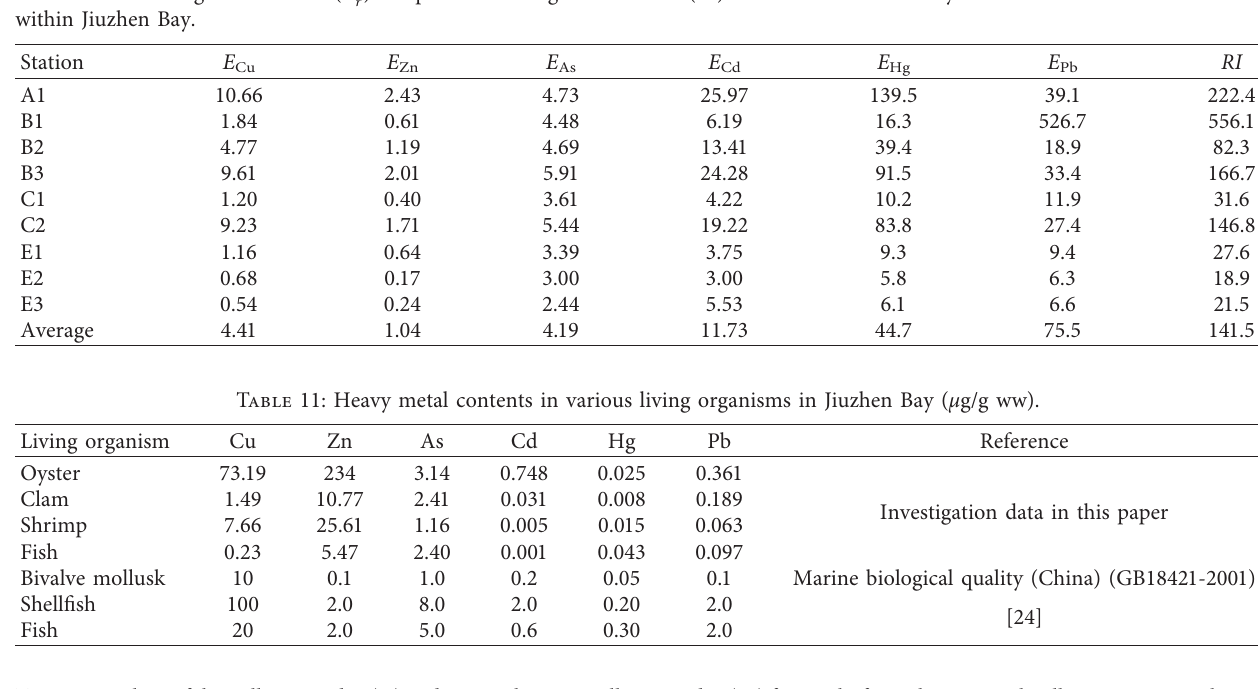
Table 12: Values of the pollution index ( P organisms.